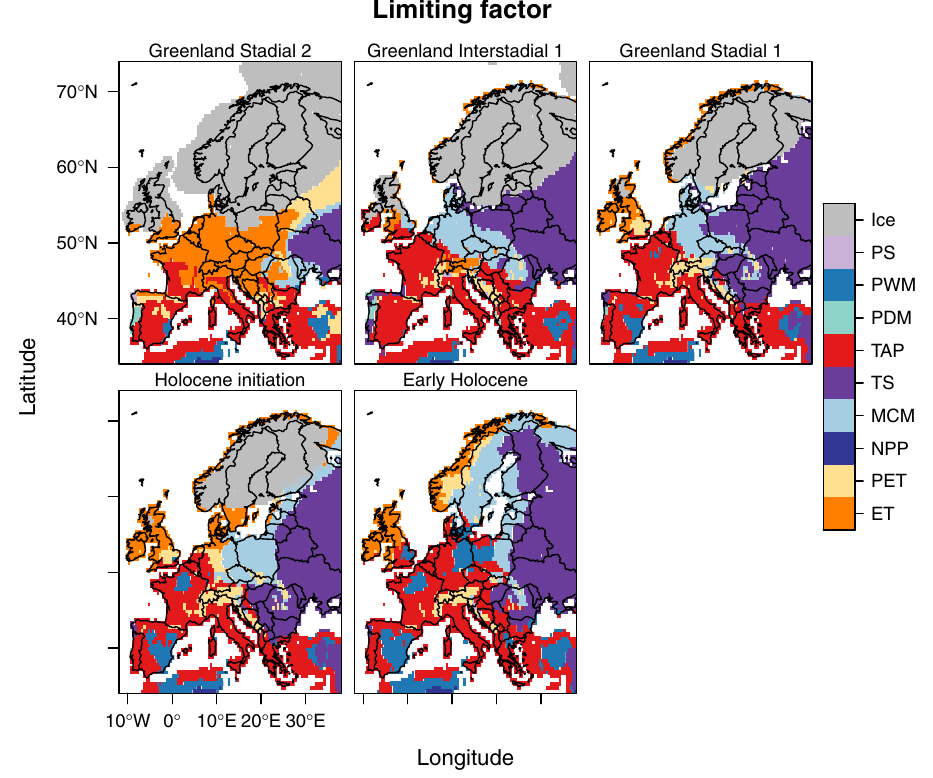
Fig. 5 | Factors limiting population density across Europe for selected times during the 21ky to 8kyBP period. Predictions based on 50th percentile general- ised additive models (qGAM). Areas in grey represent the glacier extent asderived